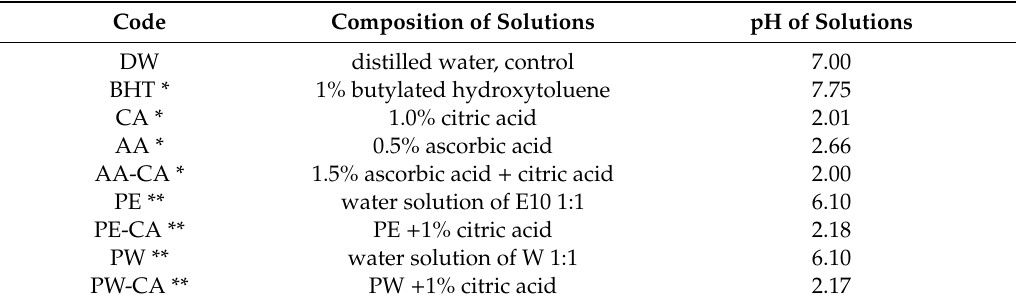
Table 1. Di ff erent preservative media used for dipping of fresh-cut apple cubes: - standard compounds; - novel compounds: water (W) and ethanol 10% (E10) extracts from potato peels (P) and control. Code Composition of Solutions pH of Solutions DW distilled water, control 7.00 BHT * 1% butylated hydroxytoluene 7.75 CA * 1.0% citric acid 2.01 AA * 0.5% ascorbic acid 2.66 AA-CA * 1.5% ascorbic acid + citric acid 2.00 PE ** water solution of E10 1:1 6.10 PE-CA ** PE + 1% citric acid 2.18 PW ** water solution of W 1:1 6.10 PW-CA ** PW + 1% citric acid